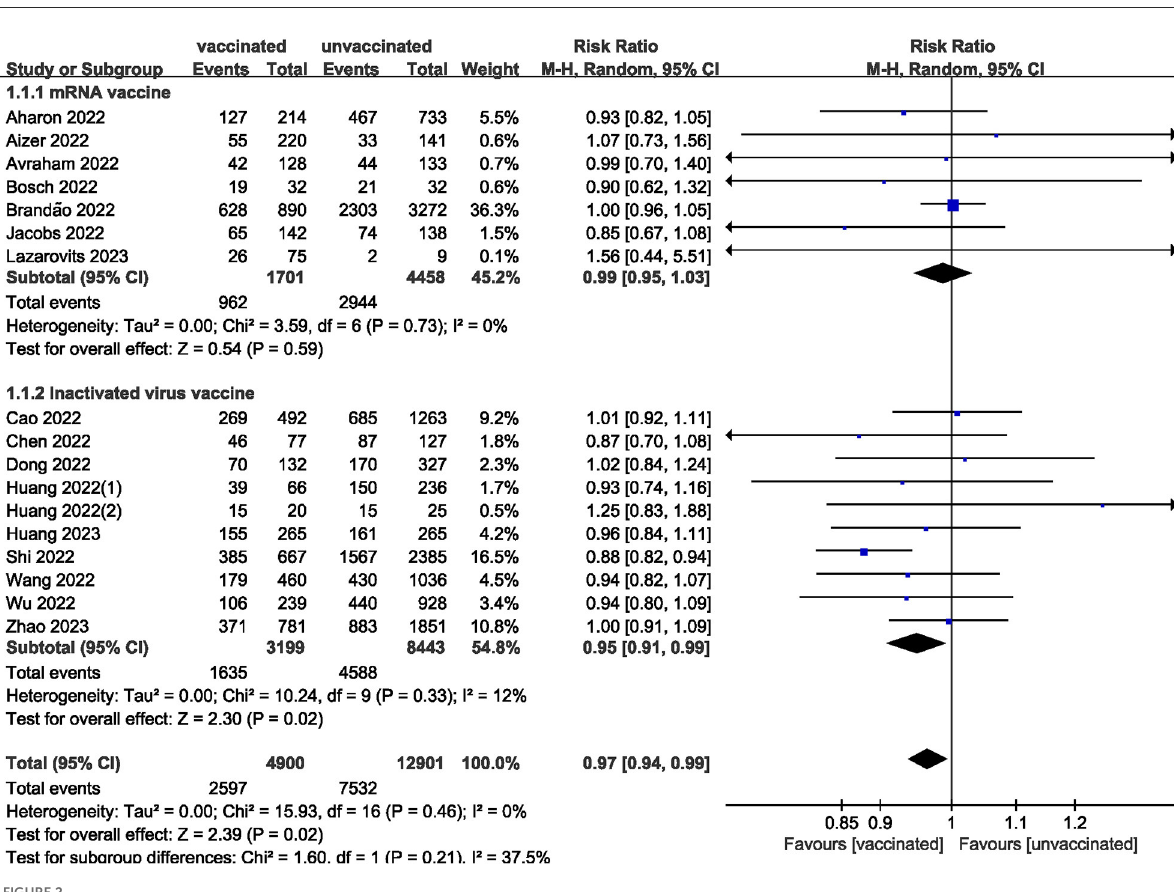
FIGURE2 Forest plot of clinical pregnancy rate for vaccinated vs. unvaccinated.